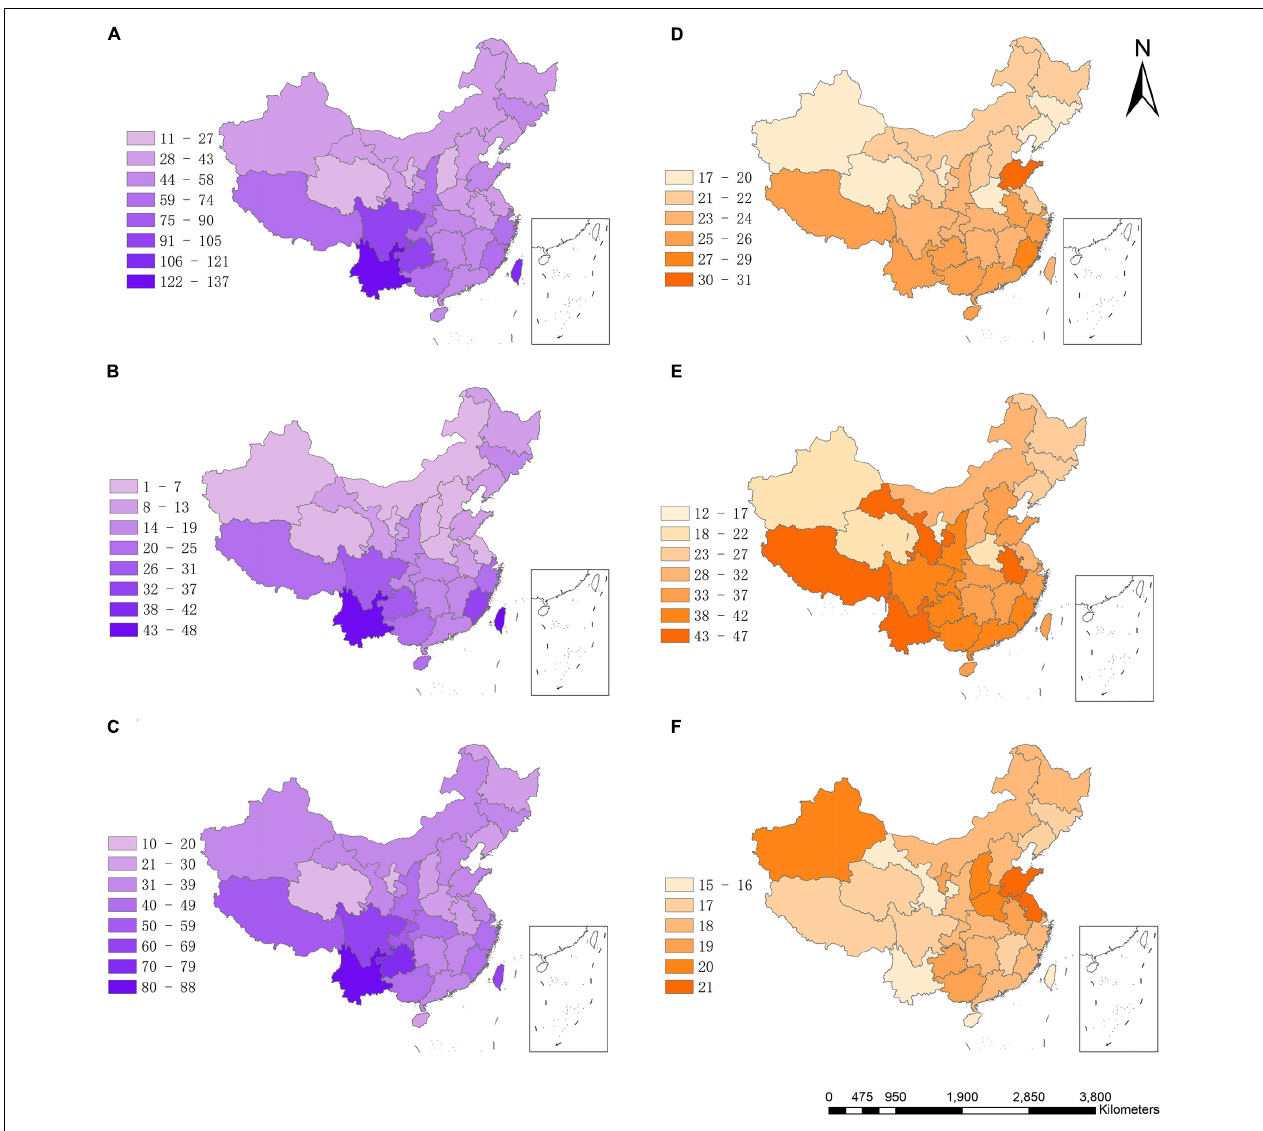
FIGURE 1 | Geographic pattern of species richness and species differentiation rate of bryophytes in China. (A) Species richness of all bryophytes, (B) species richness of liverworts , (C) species richness of mosses, (D) diversification rates of all bryophytes, (E) diversification rates of liverworts , (F) diversification rates. Species richness = number of species/ln area.